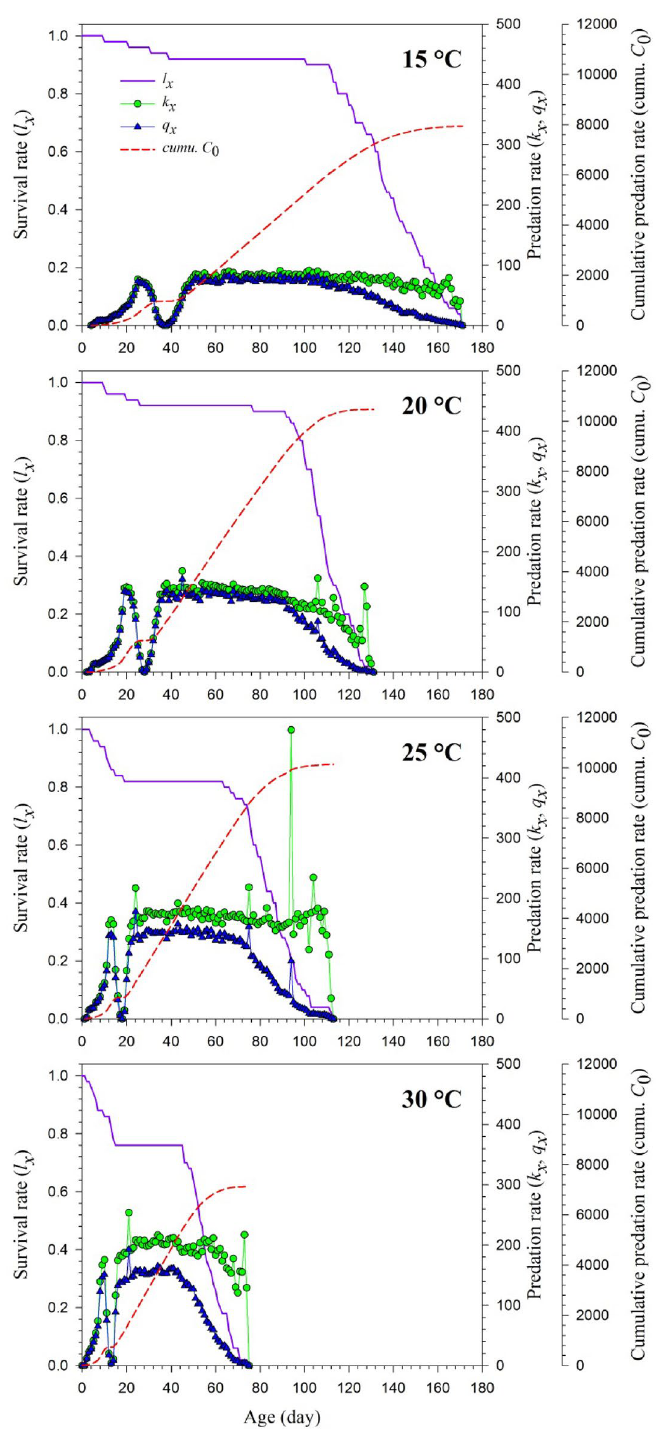
Figure 2. Age-specific survival rate ( l x ), age-specific predation rate ( k x ), age-specific net predation rate ( q x ) cumulative net predation rate ( C 0 ) of Harmonia axyridis feeding on Spodoptera litura eggs at different